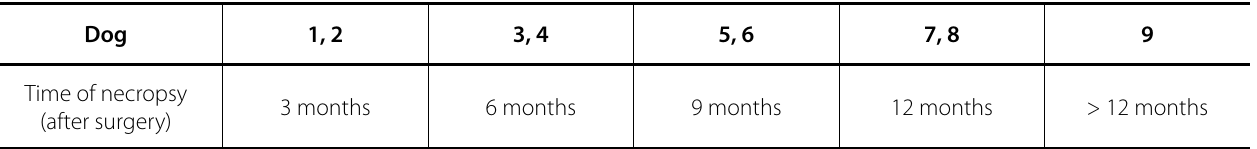
Table 1. Order and time of necropsy of